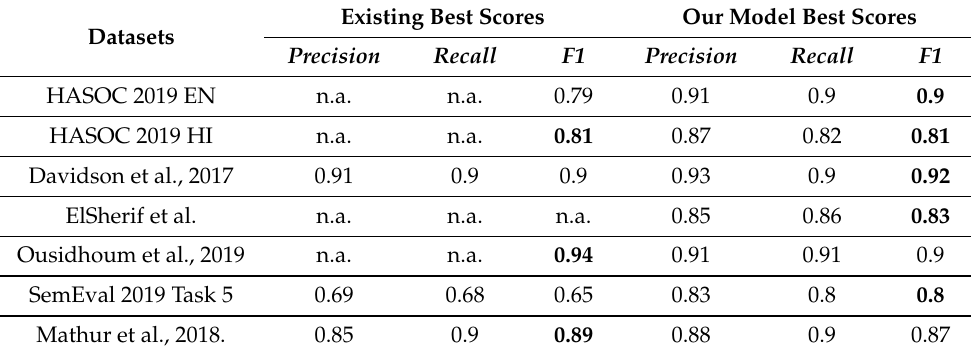
Table 10. Comparison of different dataset models with our model. Existing Best Scores Our Model Best Scores Datasets Precision Recall F1 Precision Recall F1